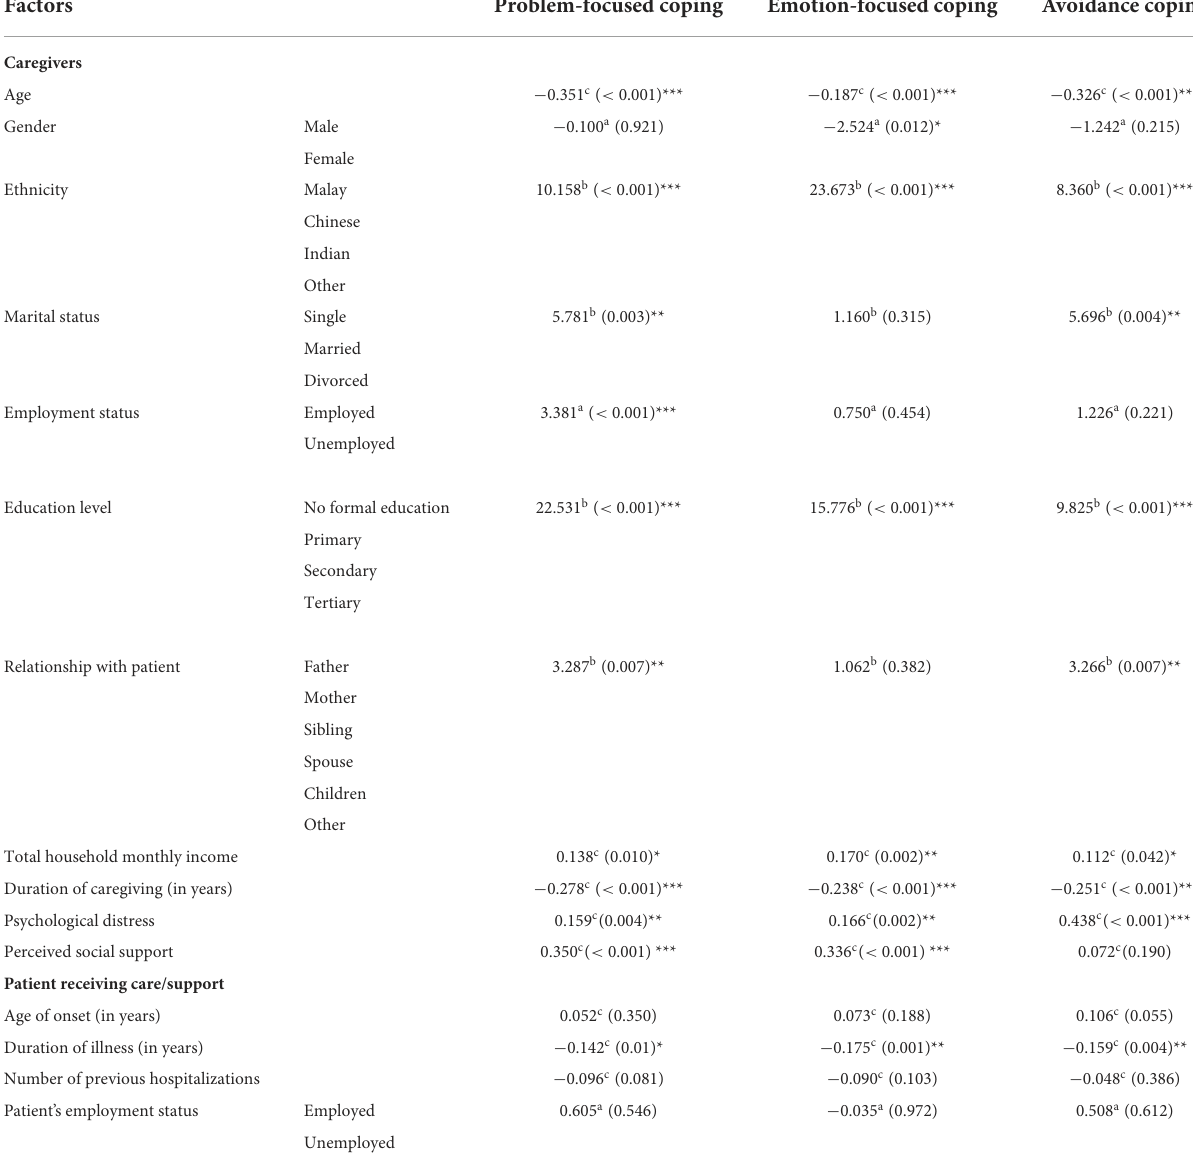
TABLE 3 Factors associated with coping strategies among caregivers of patients with schizophrenia. Factors Problem-focused coping Emotion-focused coping Avoidance